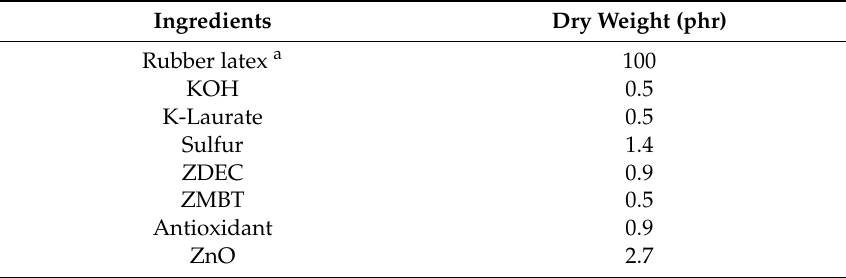
Table 2. Latex compound formulations used for preparing the natural rubber thin